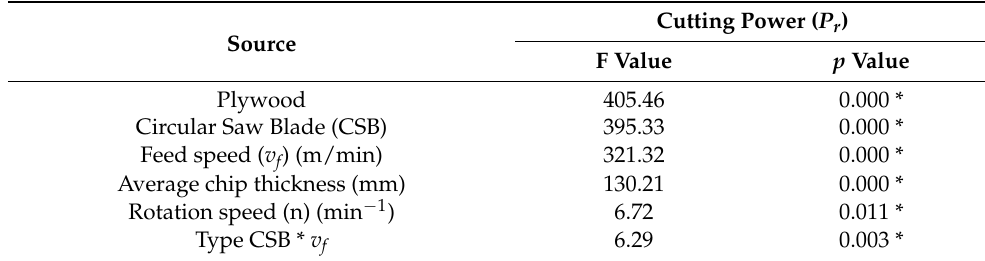
Table 4. Analysis of variance (Statistics 12) showing the influence of plywood, circular saw